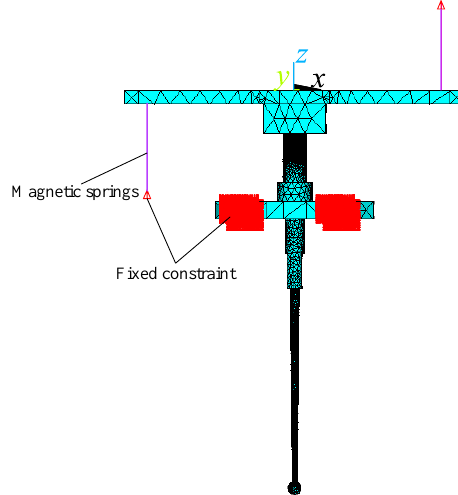
Figure 8. The finite element model of armature assembly.